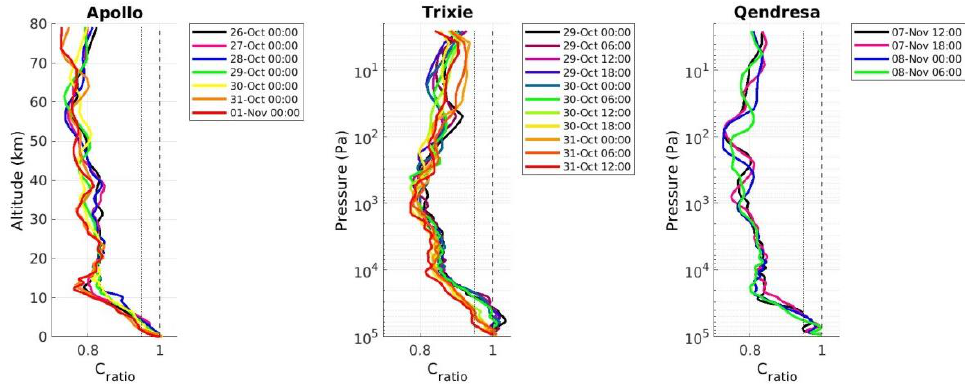
Figure 11. Same as Figure 10, but for Apollo in 2021 ( left ), Trixie in 2016 ( middle ), and Qendresa in 2014 ( right ).